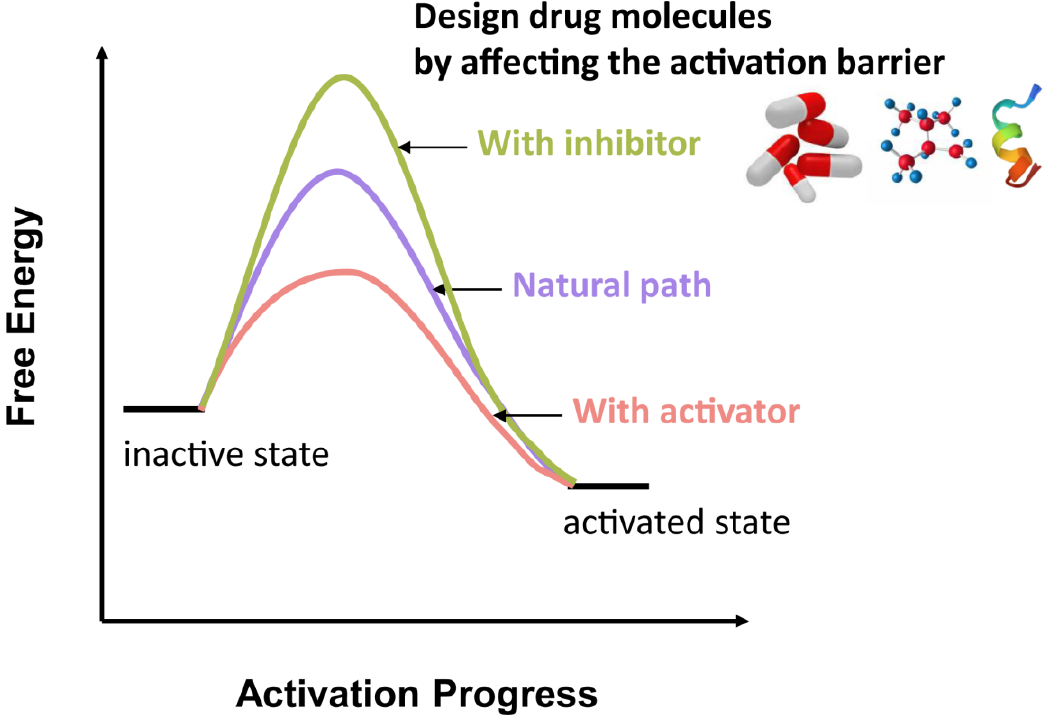
Figure 8. The drug design strategy by affecting the barrier of the protein activation process.